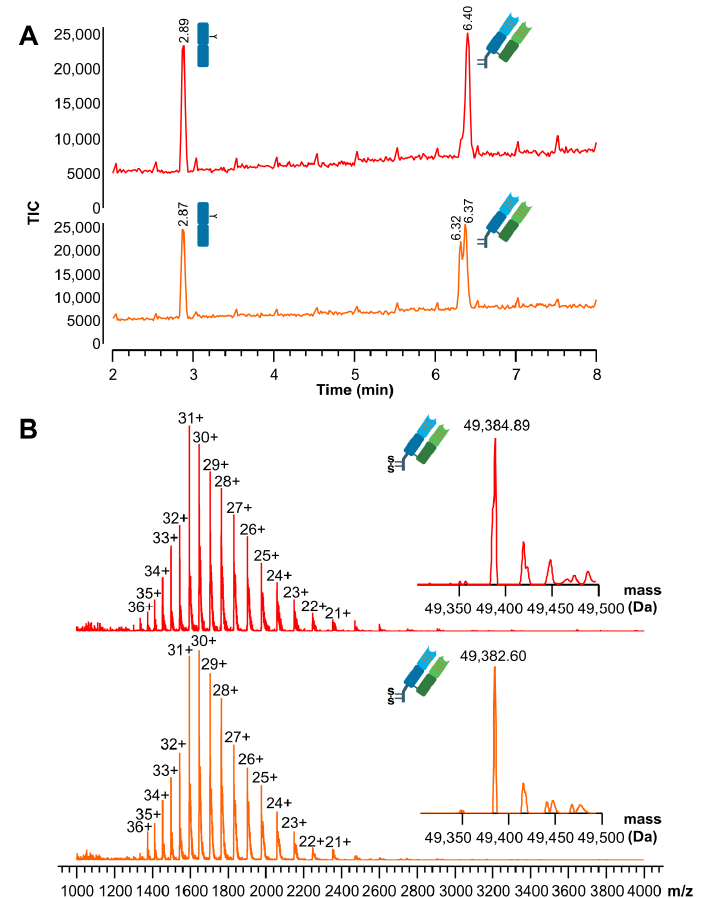
Figure 4. ( A ) Total ion chromatograms (TIC) of IdeS digested bevacizumab, dialyzed and reduced by DTT (red) or β -MEA (orange); ( B ) MS spectra with the assignment of F(ab’), reduced by DTT (red) and reduced by β -MEA (orange).